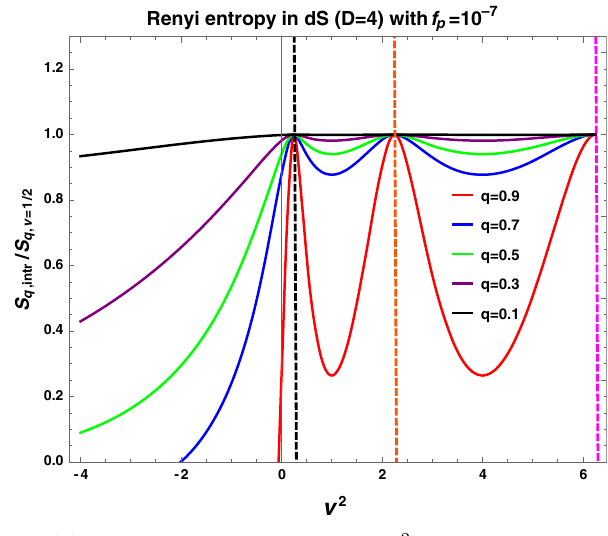
(b) Normalized R´ e nyi entropy vs ν 2 in 3+1 D de Sitter space with axionic source ( f p = 10 − 7 ). ( red ) with ‘ + ’ branch of solution of | γ p | and | (cid:17) p , n | . Here we set (cid:14) = 300. In both cases we have normalised the entanglement entropy C with the result obtained from ν = 1 / 2, which is the conformal limit